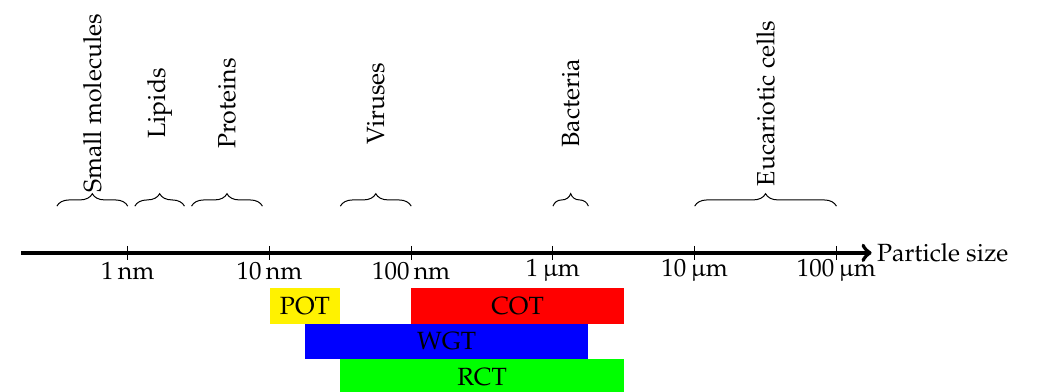
Figure 11. A scale roughly showing micro and nanometric organisms with the most convenient optical trapping techniques.